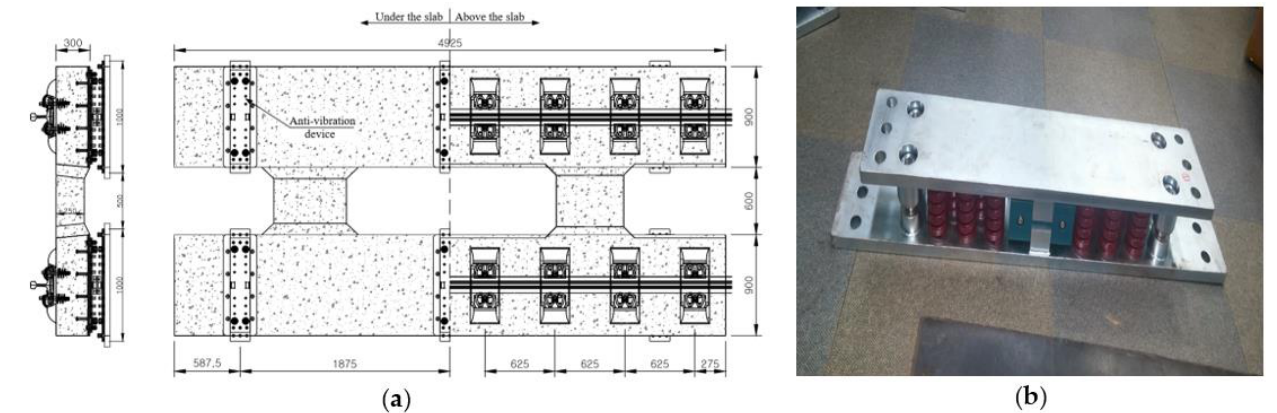
Figure 3. Precast Floating Slab Track (Type I): ( a ) Detailed structures, ( b ) Anti-vibration Device.